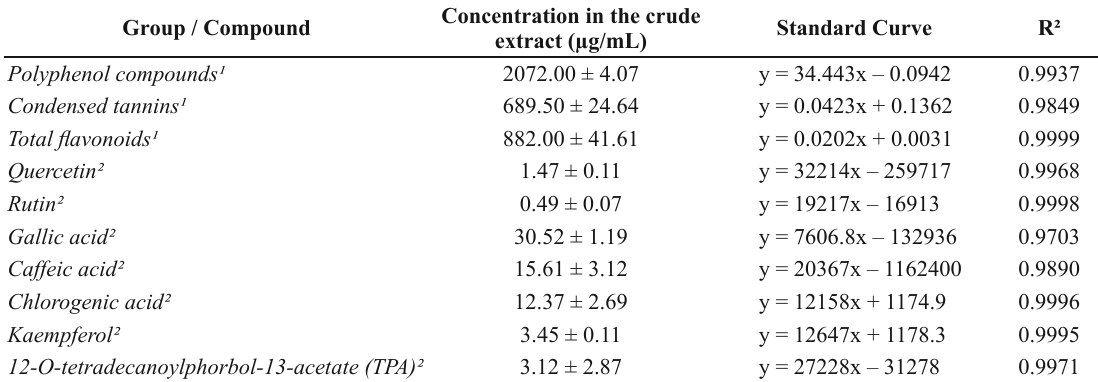
Concentrations of analytical markers present in the crude extract of Euphorbia tirucalli L.